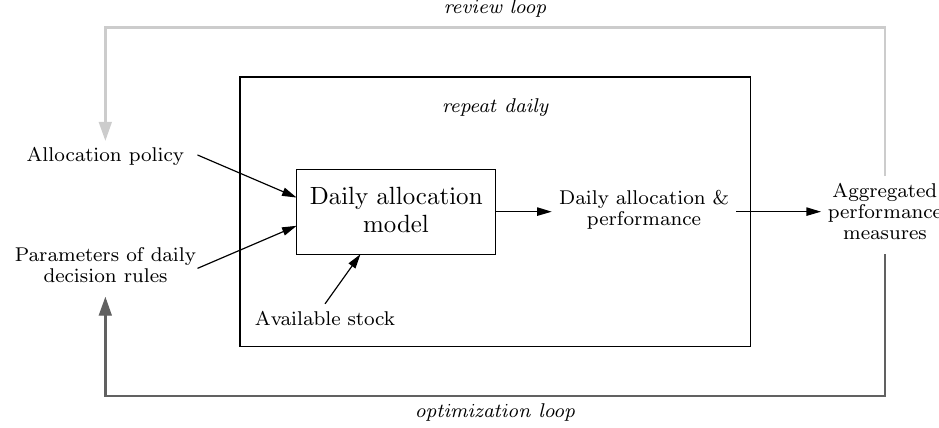
Figure 2: A broad outline of the simulation